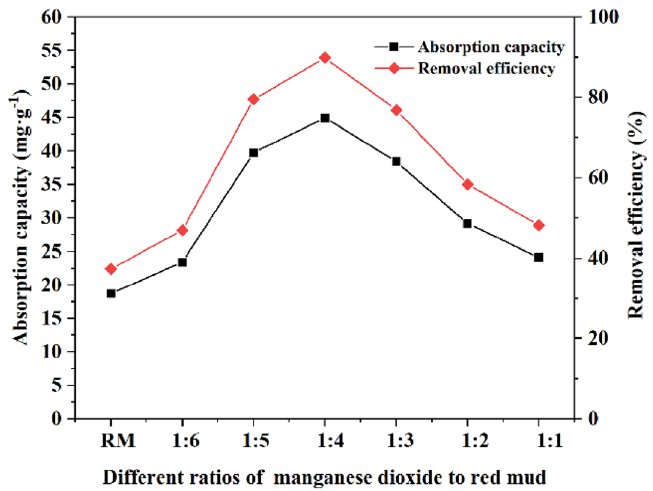
Figure 6. Effect of different ratios of manganese dioxide to red mud on adsorption of MBR at pH = 6, T = 25 °C, dosage = 1 g L −1 , t = 240 min and initial Cd 2+ concentration = 50 mg L −1 .